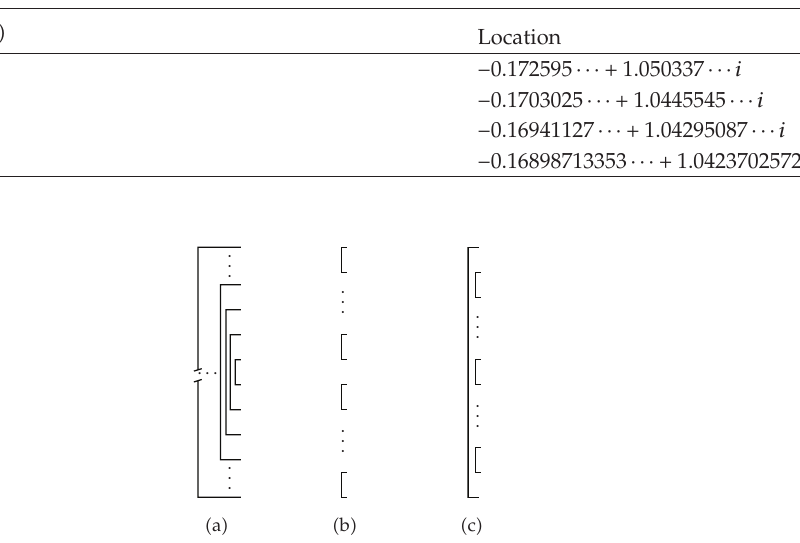
Figure 2: Canonical coupling patterns. (cid:4) a (cid:5) Nested pairs pattern. (cid:4) b (cid:5) Adjacent pairs pattern. (cid:4) c (cid:5) 1-nest- ed/adjacent pairs